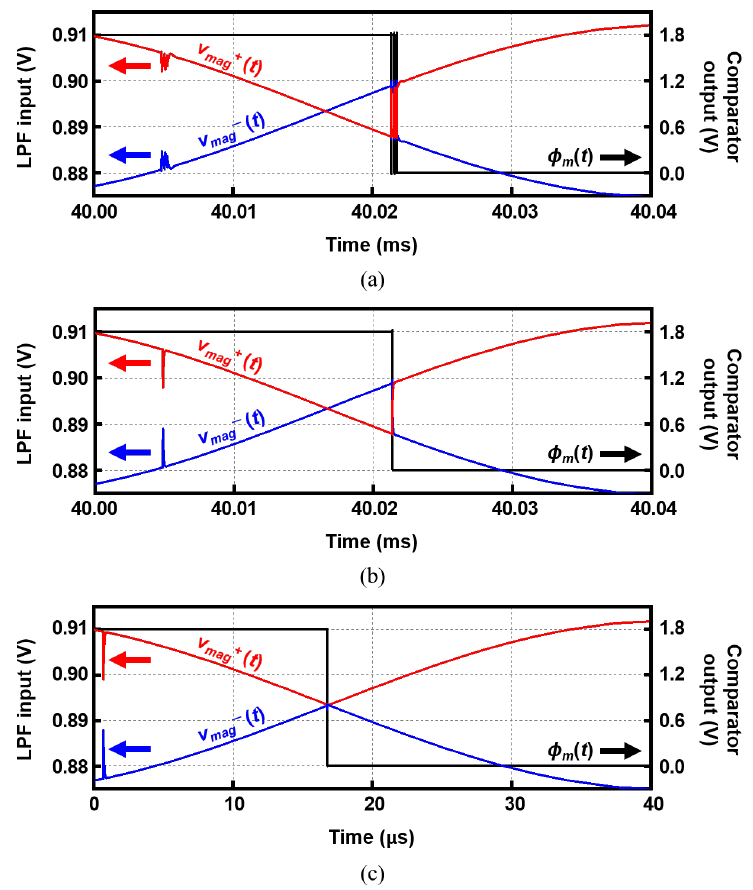
Figure 12. Transient simulation results of the output signals of the chopper and the comparator ( v + mag ( t ) , v − mag ( t ) , and φ m ( t ) ) ( a ) without and ( b ) with the buffers. ( c ) The signals with the buffers and offset cancellation by the